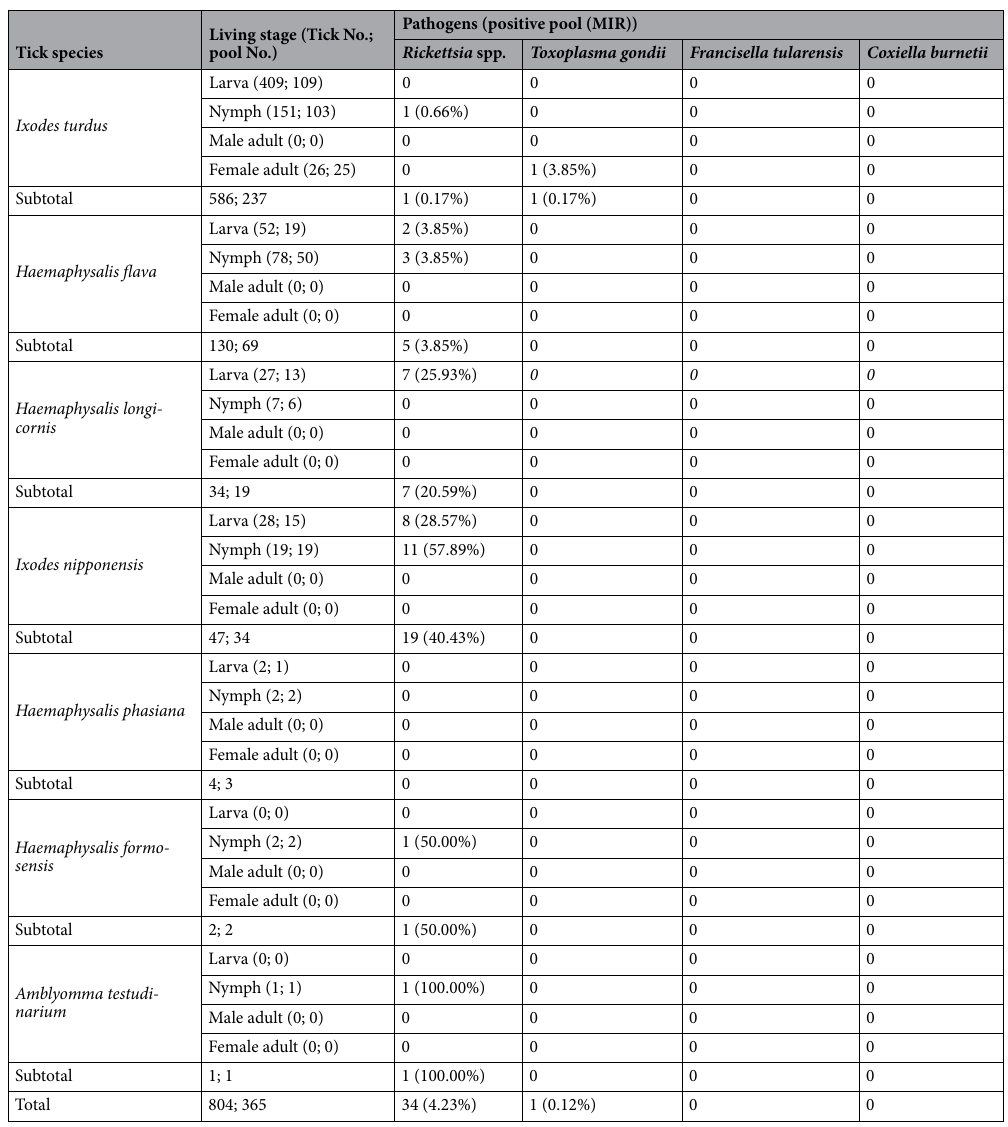
Table 1. Detection of tick-borne pathogens from ticks collected from migratory birds in the Republic of Korea. MIR = [(number of positive pools)/(total number of ticks)] ×